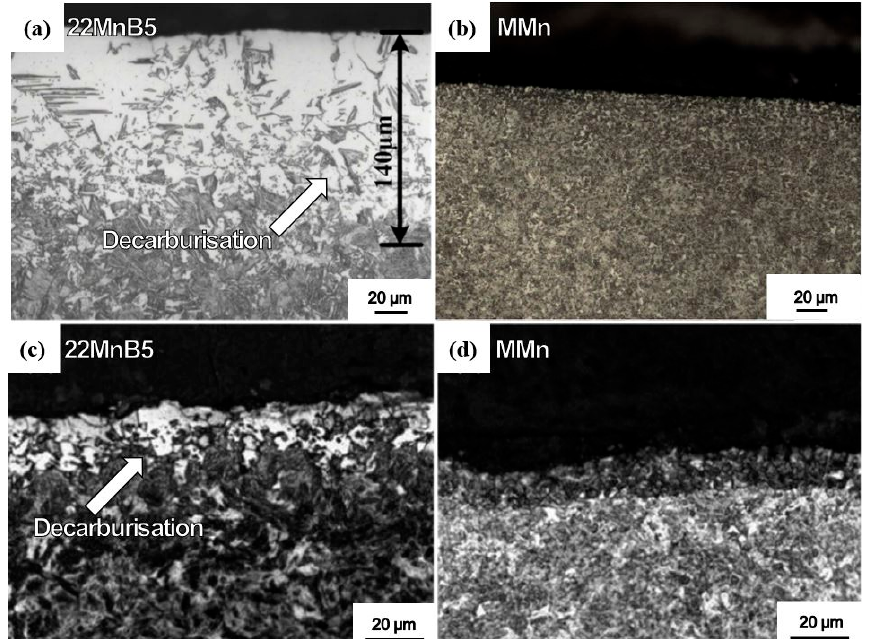
Figure 14. Optical microscopy images of cross-sectional microstructure of the surface region, showing the oxidation and decarburisation layers for: ( a , c ) 22MnB5 steel; ( b , d ) MMn steel; the samples in ( c , d ) are heated under a protective nitrogen atmosphere (Adapted with permission from Elsevier, John Wiley and Sons [103,143]).